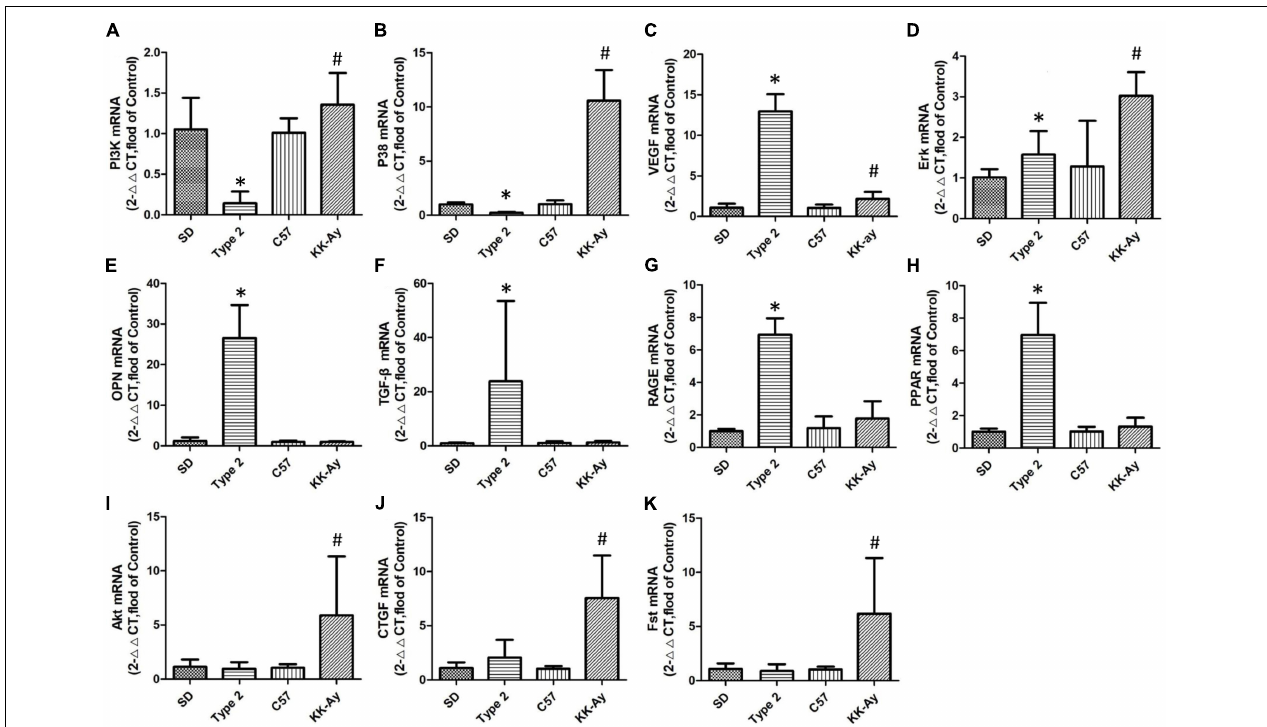
FIGURE 7 | Relative mRNA levels of selected genes in T2DM rats and KK-Ay mice. Quantitative real-time PCR of the 5 samples were conducted 3 times and normalized to GAPDH gene expression, measured with 2 ∧ ( − (cid:49)(cid:49) Ct) value. (A) PI3K mRNA, (B) P38 mRNA, (C) VEGF mRNA, (D) Erk mRNA, (E) OPN mRNA, (F) TGF- β mRNA, (G) RAGE mRNA, (H) PPAR mRNA, (I) Akt mRNA, (J) CTGF mRNA, and (K) Fst mRNA. Data are shown as the mean ± SE of 3 independent replicates. Significant differences ( ∗ P < 0.05, or # P < 0.05) between model group and corresponding control